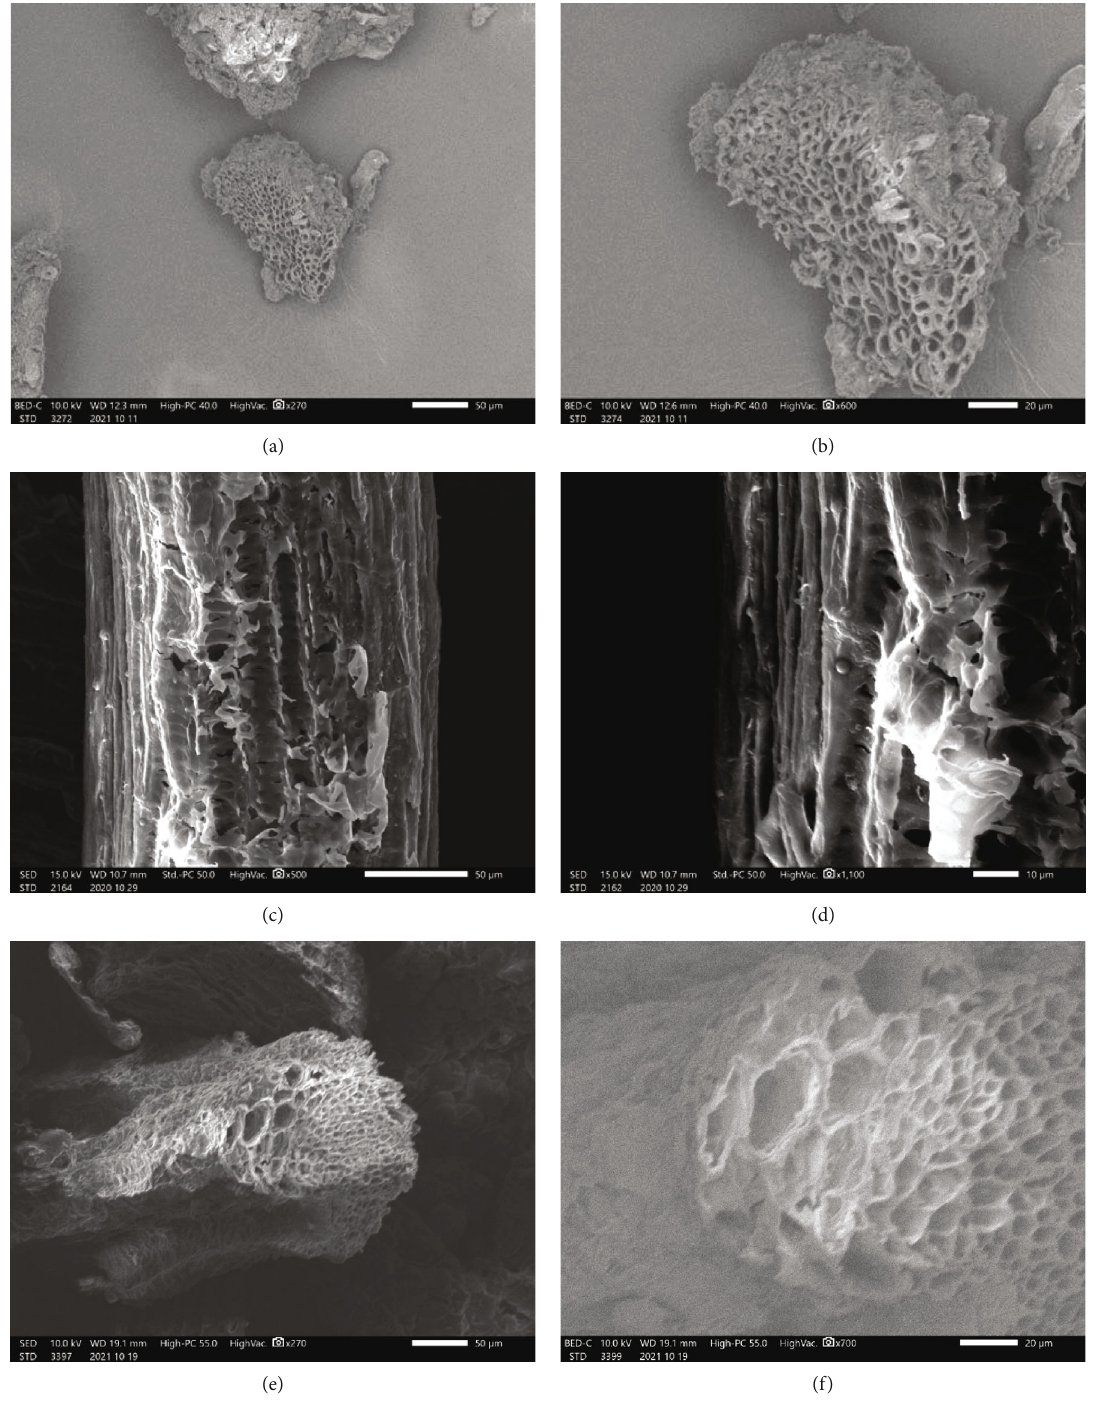
Figure 11: SEM images of pure ((a, b) PFS) and treated ((c, d) NAFS and (e, f) SAFS) fennel seed adsorbents after